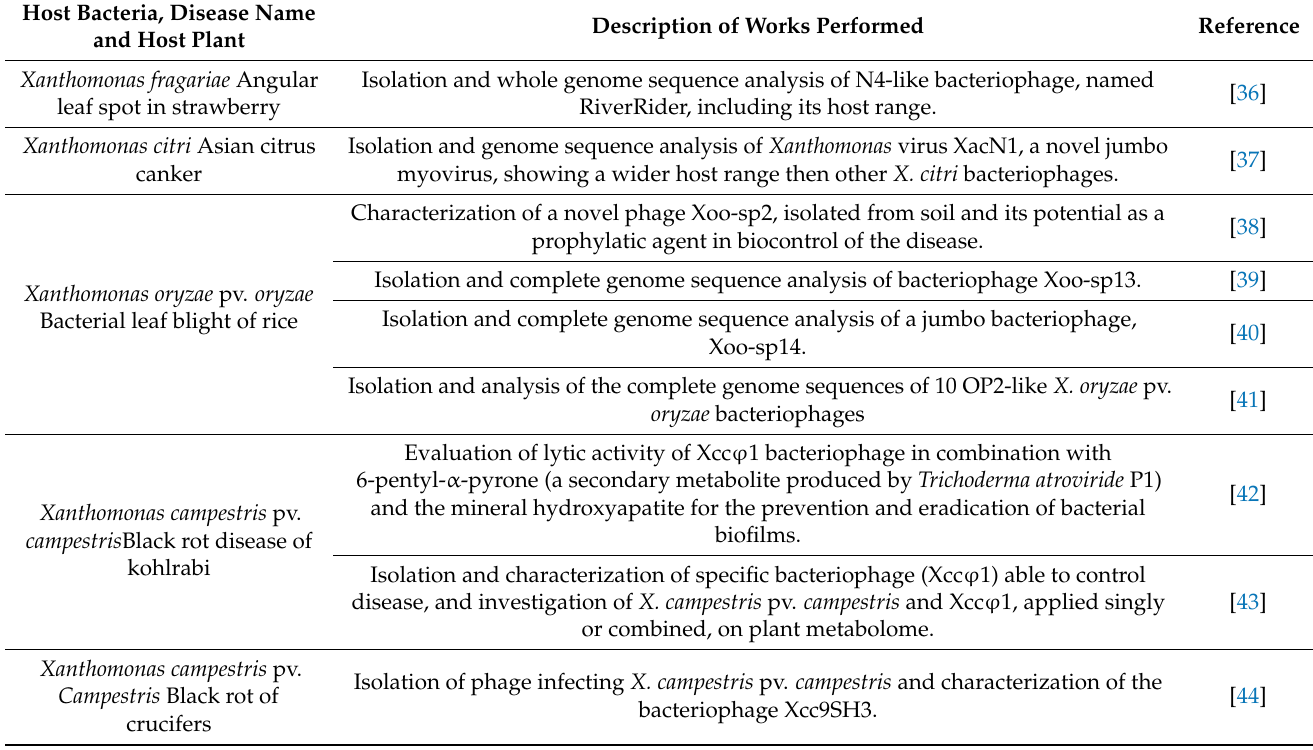
Table 1. List of recent publications on bacteriophages against Xanthomonas